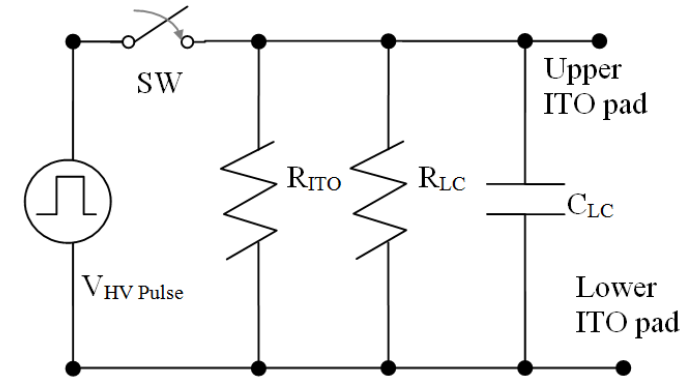
Figure 17. The equivalent circuit for the sample in the high-voltage